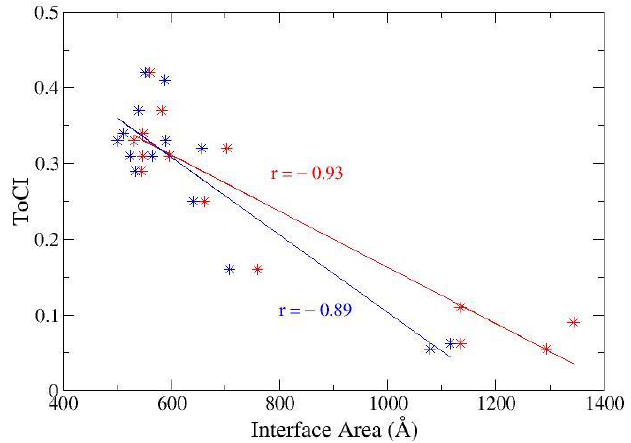
Figure 7. Scatter plot of the ToCI vs shared area as measured by different teams red (interface area) [64], blue (buried area) [59,65]. Stars represent data, lines the linear regression fittings, r is the correlation value.